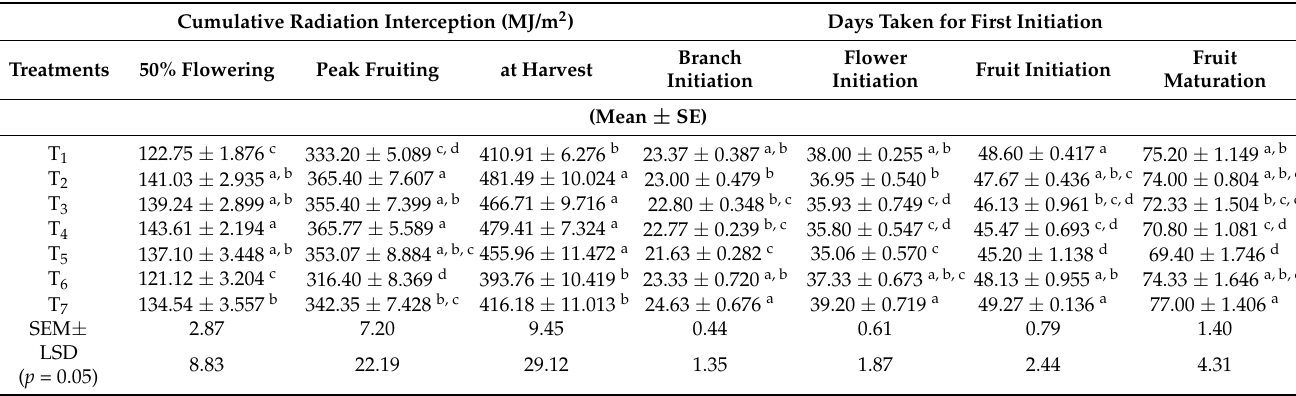
Table 5. EffectofelevatedCO 2 andtemperatureoncumulativeradiationinterceptionandphenologicalstages initiation of tomato. Cumulative Radiation Interception (MJ/m 2